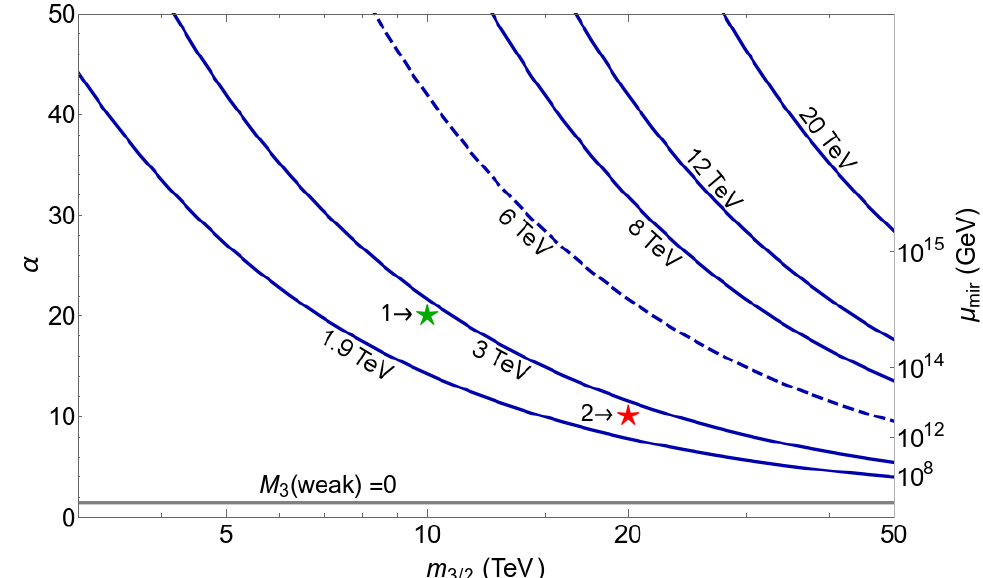
Figure 1 . Contours of M 3 (weak) in the (cid:11) vs. m plane of the GMM model. The region below 3 = 2 M 3 (cid:24) 1 : 9 is excluded by LHC gluino pair searches. The locations of the benchmark points mini1 and mini2 are shown by green and red stars, respectively. The region below the dashed M 3 (cid:24) 6 TeV contour has the capacity to be natural. On the right side, some corresponding values of (cid:22) mir are